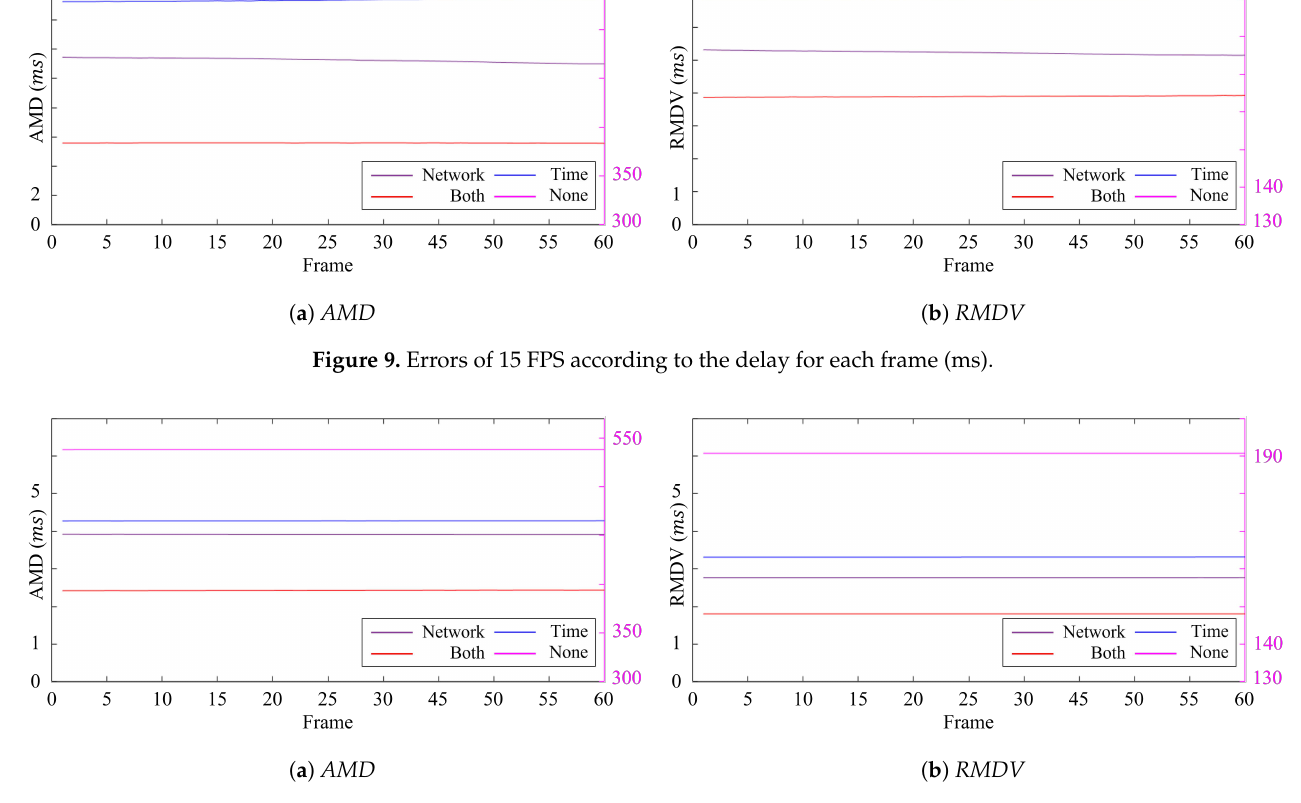
Figure 10. Errors of 45 FPS according to the delay for each frame